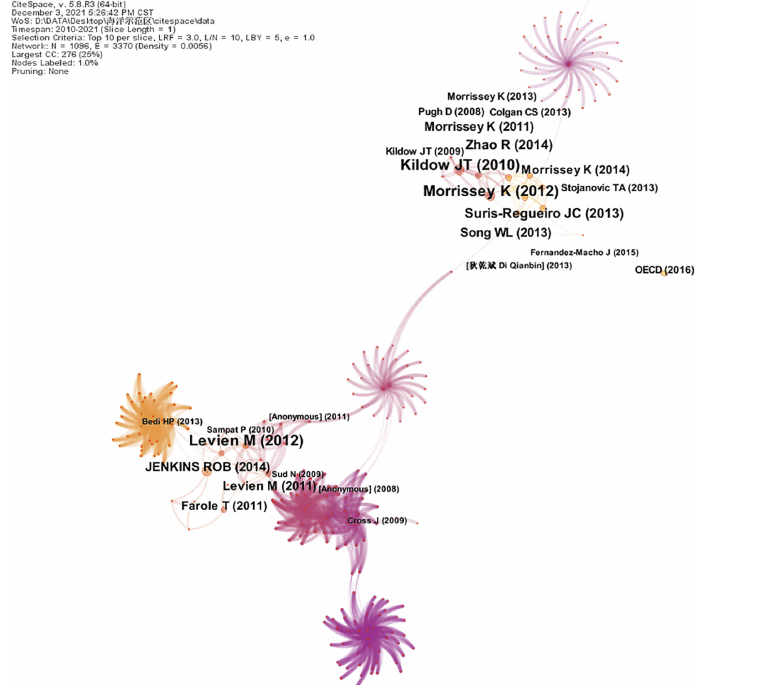
Figure 8. Literature co-citation